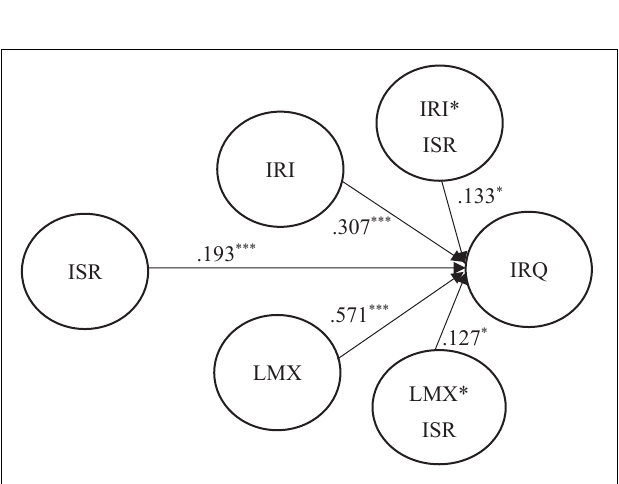
FIGURE 3 | Structural model on mainland China employees. ∗ p < 0.05 and ∗∗∗ p <